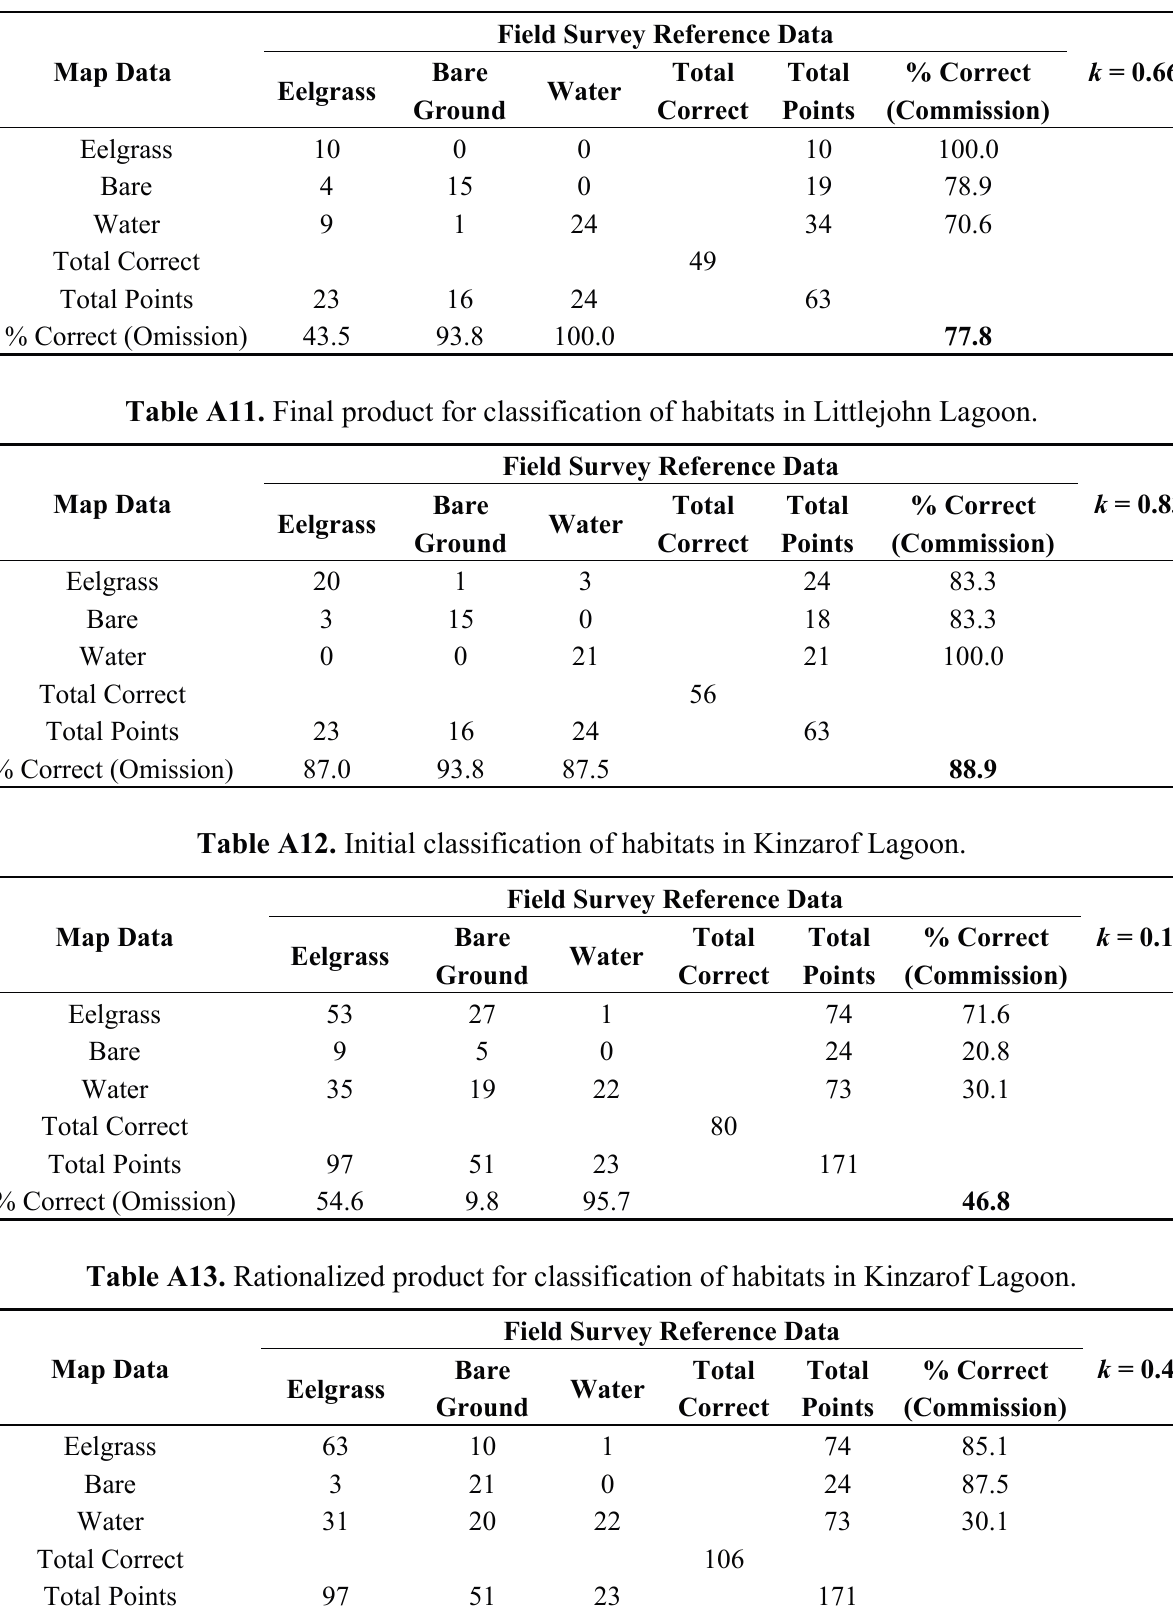
Table A10. Initial classification of habitats in Littlejohn Lagoon.